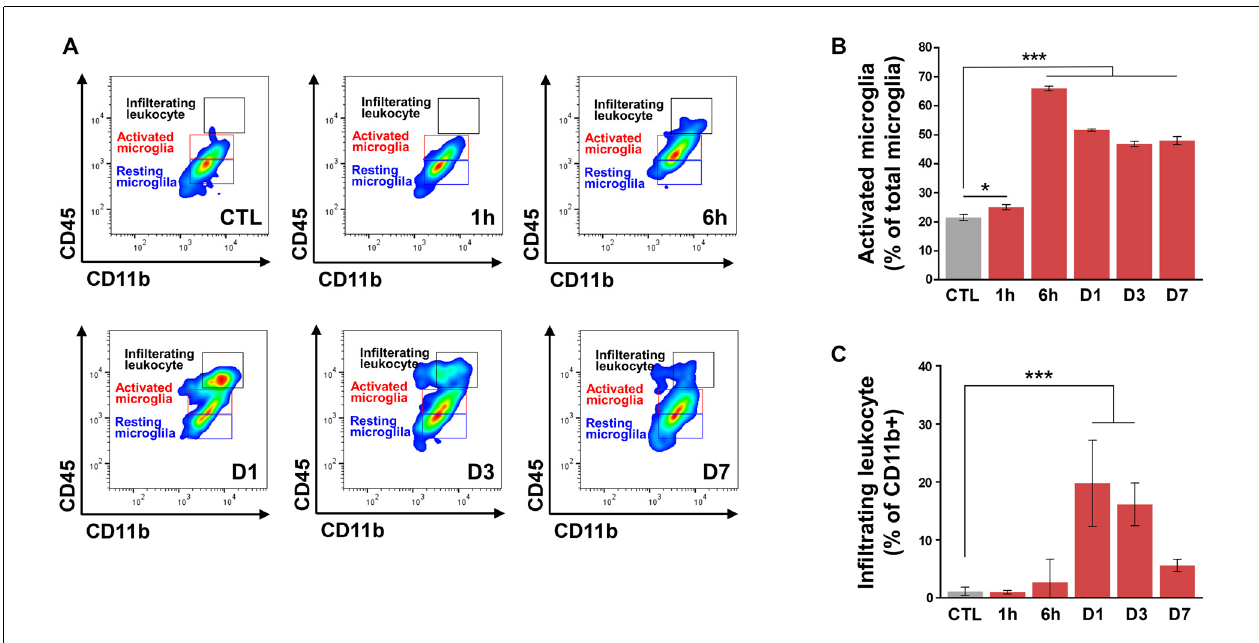
FIGURE 3 | Flow cytometry of retinal cells from control and choroidal neovascularization (CNV) retinal cells to detect microglial activation and infiltrating leukocytes. (A) Single live cells were selected and sorted according to their CD11b and CD45 status. Plot CTL, non-CNV control; plot 1 h, 6 h, D1, D3, and D7 after CNV induction. (B) The ratio of activated microglia (CD11b + CD45 int ) to total microglia started to increase very early after CNV induction at 1 h, peaked at 6 h, and remained significantly increased through D7. (C) Compared with the control, the proportion of infiltrating leukocytes (CD11b + CD45 high ) in CD11b + cells increased on